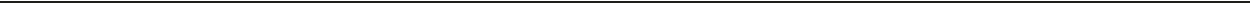
Fig. 1 Ancestral reconstruction and functional characterisation of nucleotide transporters. a Schematic representation showing the position of the nodes in the NTT phylogenetic tree for which ancestral sequences (AncNTT Roz/Mic and AncNTT Mic ) were inferred and functionally characterised. We obtained point estimates of the ancestral NTT protein sequences by selecting the amino acid with the highest posterior probability at each site in the alignment (Supplementary Data 1 and 2). b Inferred secondary structure and membrane topology of one contemporary (ThNTT4) and the two ancestral sequences, predicted using HMMTOP. c Truncated western blot of fractionated E. coli expressing different NTTs detected using an anti-HIS antibody. Ancestral gene = AncNTT = Ec, R. allomycis = Ra. Total = sonicated bacteria, Inclusions = 20,000g pellet, Membranes = 150,000 g pellet, Cytosol = Roz/Mic , E. cuniculi supernatant after 150,000 × g spin. Complete blots are shown in Supplementary Figure 4. d Kinetics of [ 32 P]-ATP uptake by ancestral NTTs expressed in E. coli ; pET16b = empty vector control. e Substrate saturation curve for the uptake of [ 32 P]-ATP in the presence of increasing concentrations of unlabelled ATP. Data is fi tted to a Michaelis – Menten equation to determine K m ( µ M) and V max (pmol/min/mg) by iteration. f Competitive substrate inhibition against [ 32 P]-ATP uptake. Competitors were at 50,000× excess over the radio-labelled ATP. Data points represent residual radioactivity within the bacteria after subtraction of the empty vector control. g Nucleotide uptake of [ 32 P]-labelled pyrimidine (dTTP and UTP) or purine (ATP and GTP) nucleotides or NAD + by the ancestral NTTs. h Effect of the protonophore CCCP on [ 32 P]-nucleotide uptake by the two ancestral proteins and PamNTT5 of Protochlamydia . Signi fi cant difference (*) to the control was only seen for PamNTT5 ( p < 0.05; one-way ANOVA). i Back-exchange assay whereby [ 32 P]-ATP-loaded E. coli expressing AncNTT Roz/Mic were incubated in the presence or absence ( = Buffer) of unlabelled ATP. Data shows residual intracellular label in harvested E. coli cells. All data points represent means ± SD of at least three independent